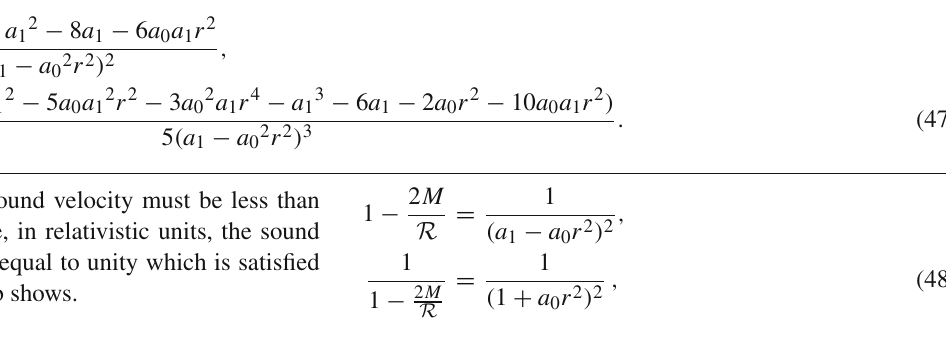
Variation of gravitational forces of Eq. (42) against radial coordinate Fig. 12 Schematic plot of the radial coordinate r in the unit of km tangential sound speed which have values less than one in the rela- tivistic unit, c the SEC, WEC, NEC and DEC, d the gravitational, versus: a the gradient of density, radial and tangential pressures of (42) which ensure that all of them have negative values, b the radial and